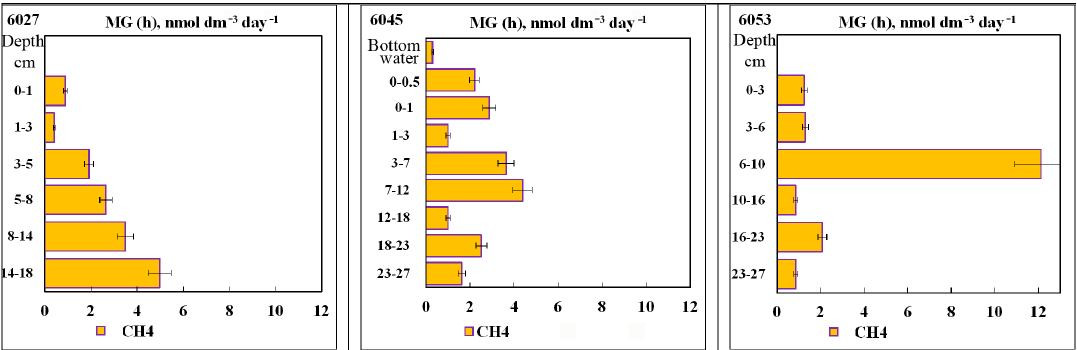
Figure 9. Rates of autotrophic (hydrogenotrophic) methanogenesis (MGh), nmol dm − 3 day − 1 ) in the Laptev Sea shelf